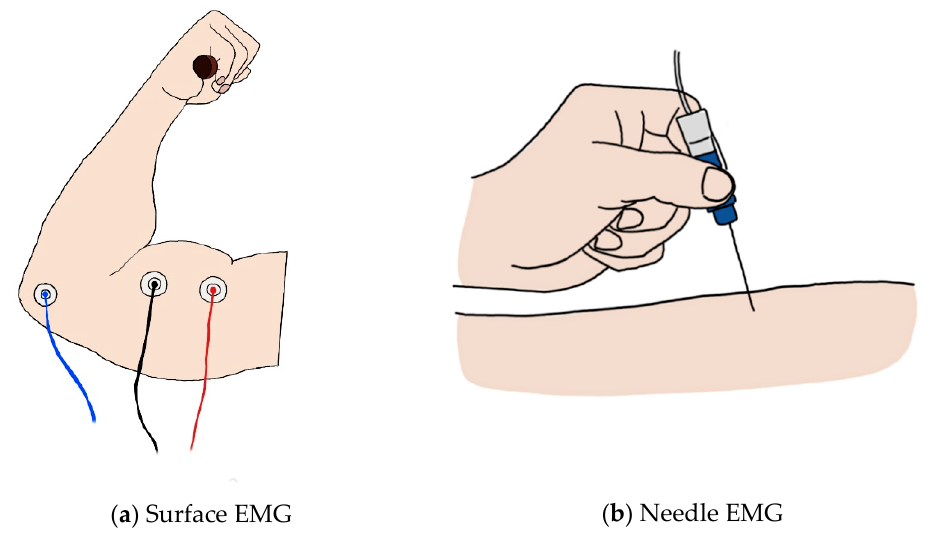
Figure 2. ( a ) Image of surface EMG: the red and black lines represent the + and − electrodes, and the blue line represents the ground; ( b ) image of the needle EMG.